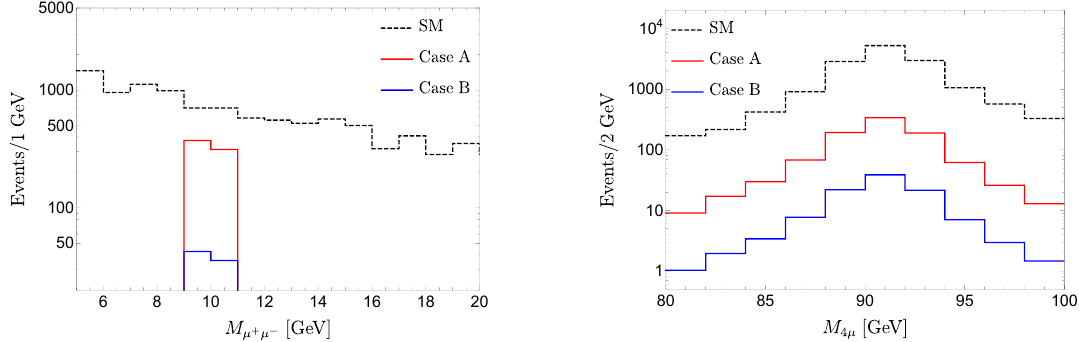
Figure 5. Distributions of the reconstructed M Z 0 (left) and M 4 (cid:22) (right) at the HL-LHC with p s = 14 TeV and L = 3000 fb (cid:0) 1 for M Z 0 = 10 GeV and g 0 = 0 : 002, for Case A (red curves) and Case B (blue